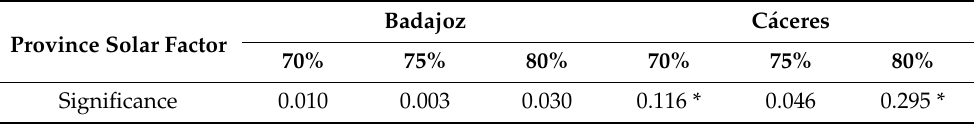
Table 6. Shapiro–Wilk’s test results for data categorized by